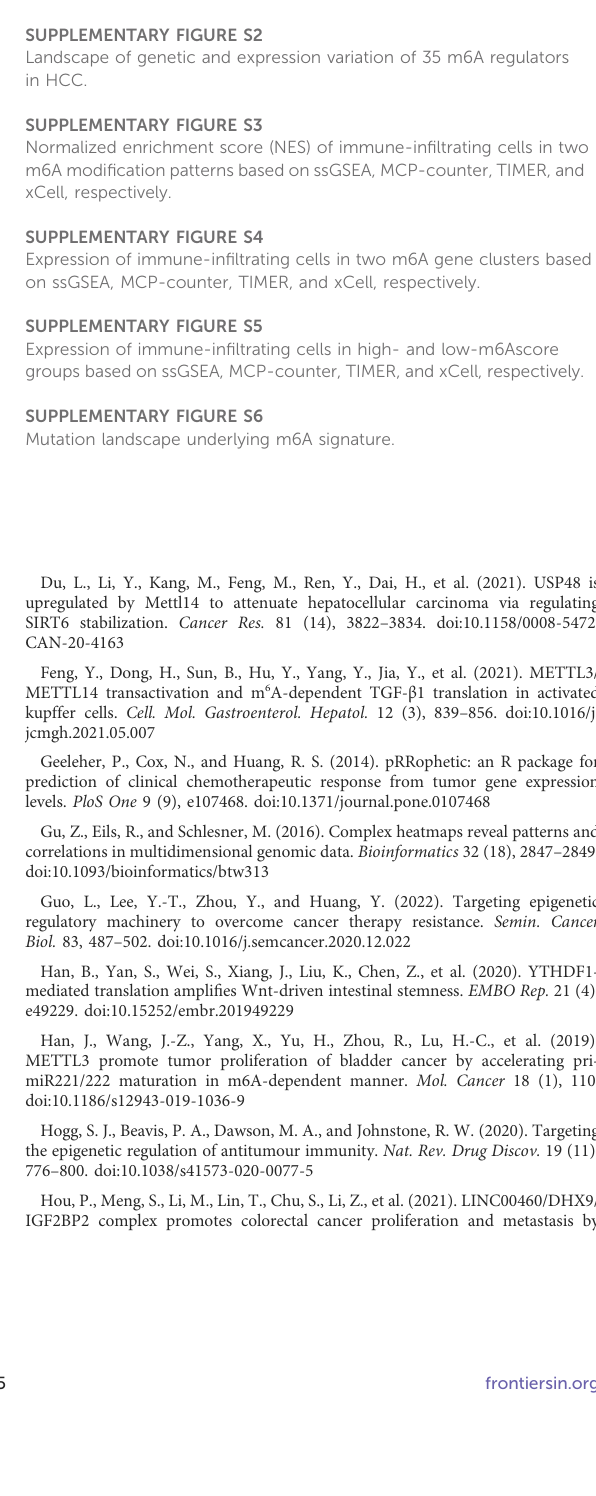
SUPPLEMENTARY FIGURE S1 Work fl ow of our study. SUPPLEMENTARY FIGURE S2 Landscape of genetic and expression variation of 35 m6A regulators in HCC. SUPPLEMENTARY FIGURE S3 Normalized enrichment score (NES) of immune-in fi ltrating cells in two